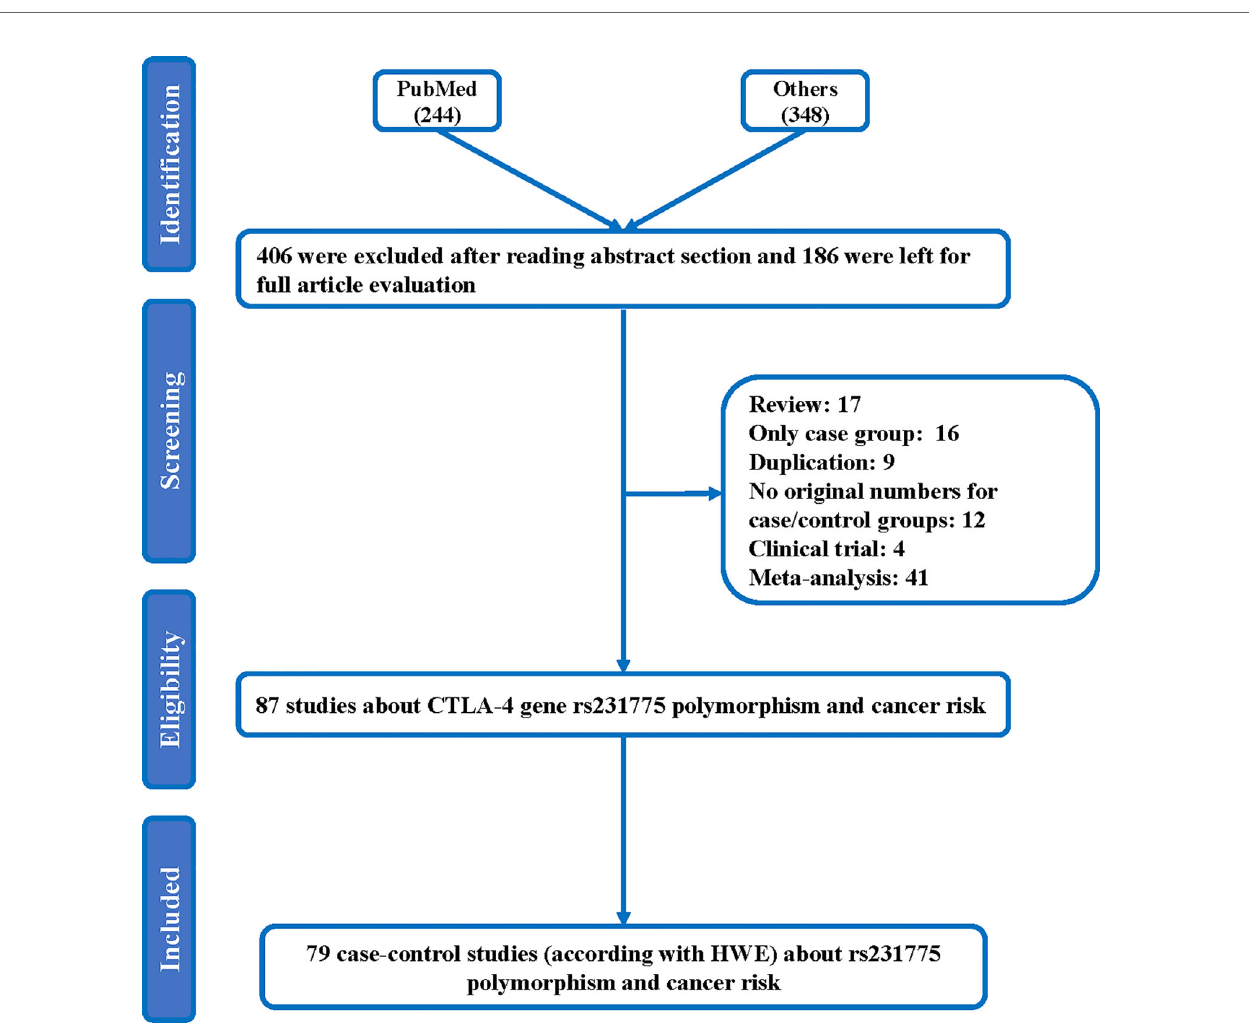
FIGURE 1 | Flowchart illustrating the search strategy used to identify association studies for CTLA-4 rs231775 polymorphism and the total cancer